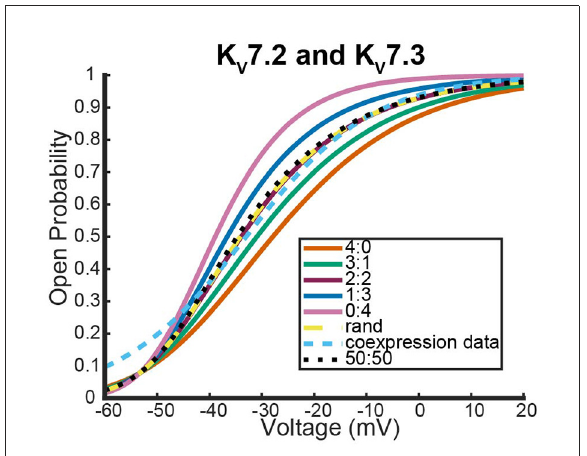
FIGURE8 Steady state probability curves as a function of voltage for cells containing various channel types. The coexpression data and homomeric data for model fitting was taken from Mani et al. (2016). The steady state probability curves presented here are for homomeric K v 7.4 (4:0) and K v 7.5 (0:4) channels, heteromeric K v 7.4 / 7.5 channels (3:1, 2:2, 1:3), the model output of a random assembly of K v 7.4 and K v 7.5 subunits expressed in 50:50 ratio (rand), the data output of a 50:50 expression of K v 7.4 and K v 7.5 subunits (coexpression data), and a model output of an equal split between only homomeric channels (50:50). Curve color and type are shown in the legend. Homomeric channels and their related heteromers being looked at are also detailed in figure title.